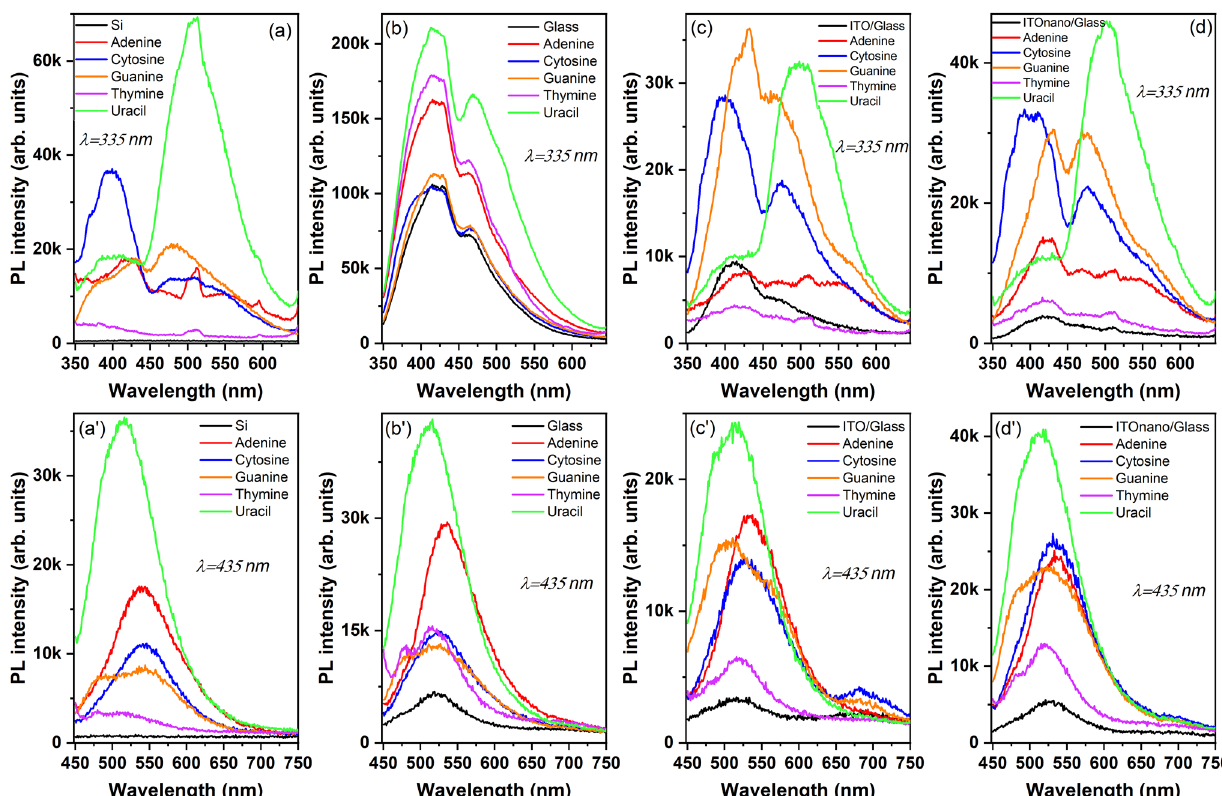
Figure 7. Photoluminescence spectra of nucleobases thin films deposited by VTE on silicon, glass, ITO/glass, ITOnano/glass at two excitation wavelength: 335 nm ( a – d ); 435 nm ( a’ – d’